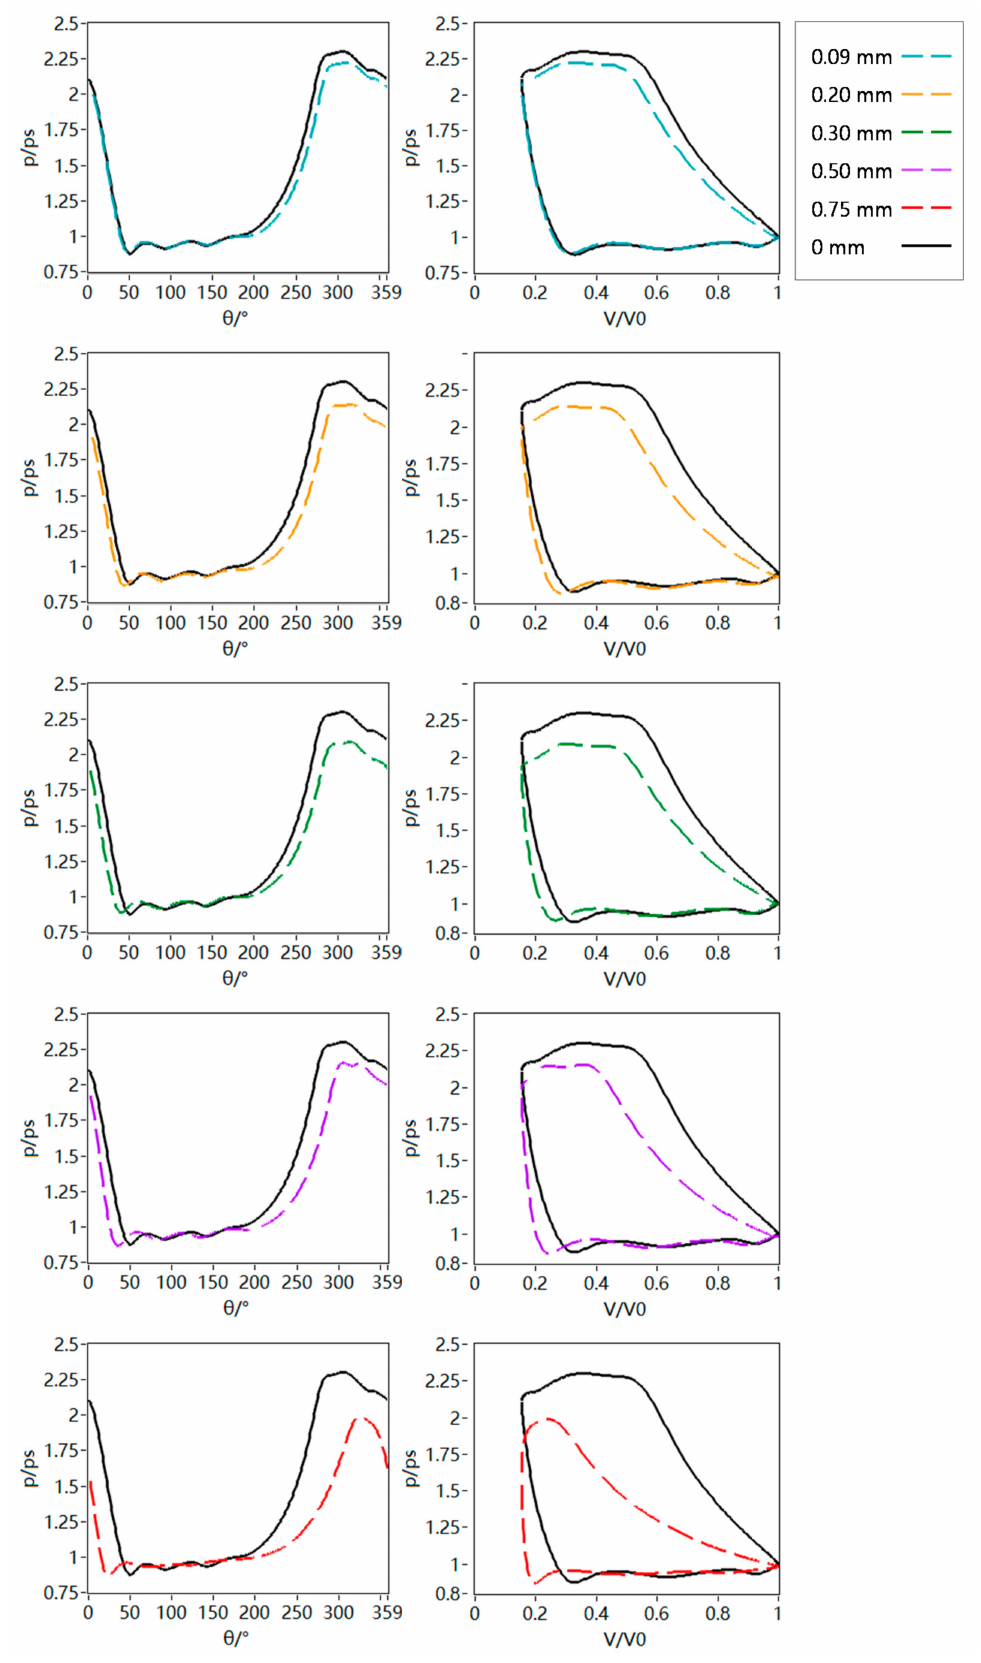
Figure 9. Comparison of p − θ and p − V diagrams between valve leakage faults of different severity and health